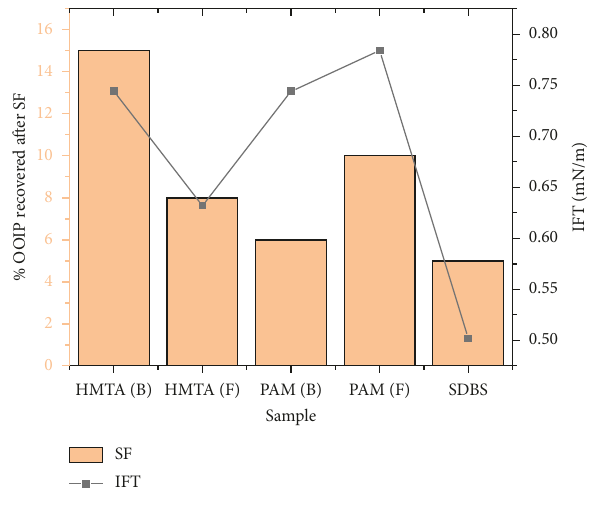
Figure 7: Oil recoveries and IFT of the